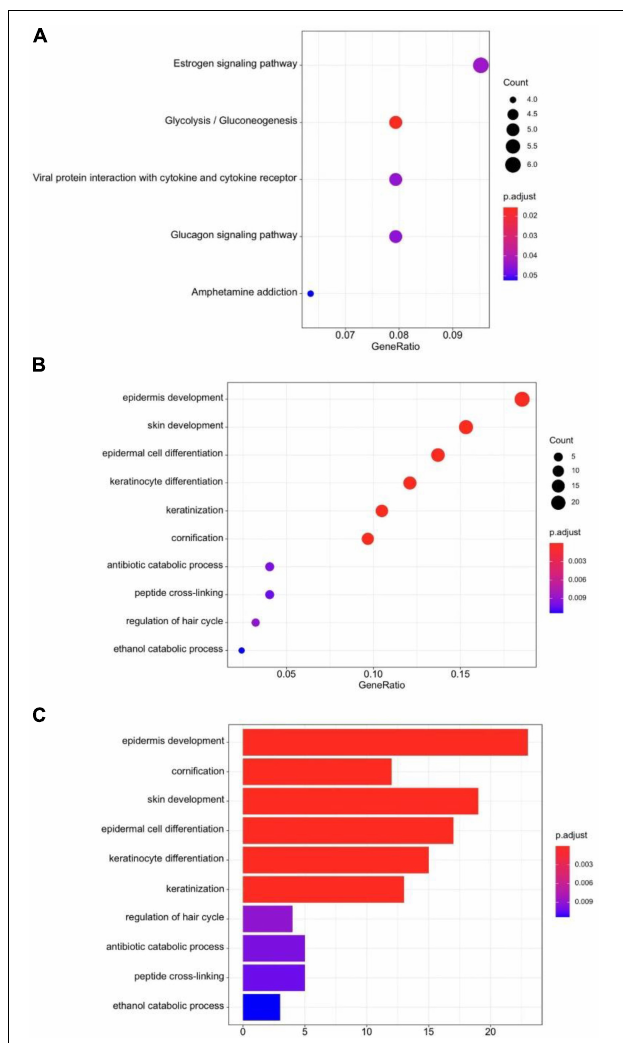
FIGURE 4 | (A) KEGG dot-plot of functional enrichment in co-related pathways analysis of DEGs. (B) GO dot-plot of functional enrichment in co-related pathways analysis of DEGs. (C) GO bar-plot of functional enrichment in co-related pathways analysis of